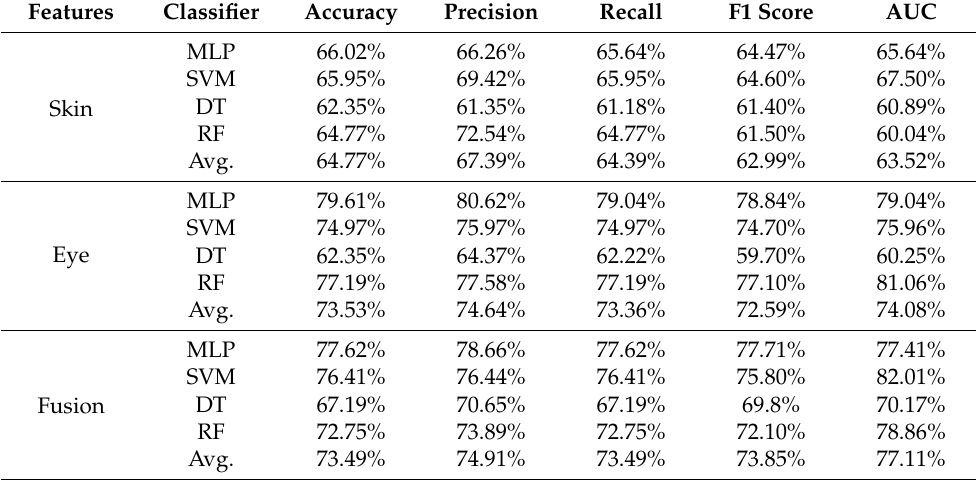
Table 5. Performance evaluation of traditional machine learning models with different types of